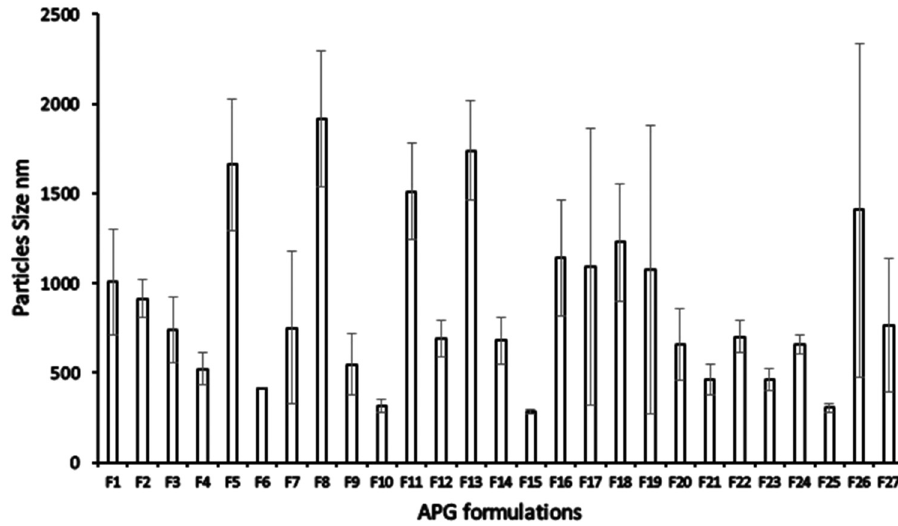
Figure 2: Particles size of di ff erent APG nanoparticle